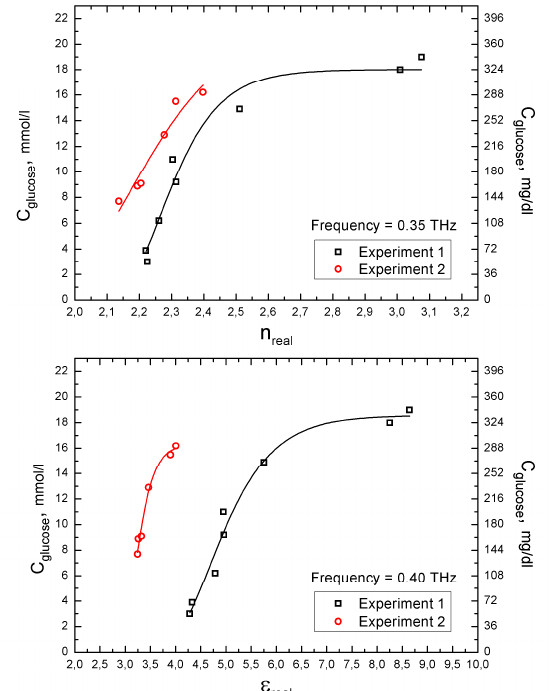
Fig. 2. Correlation behavior repeatability: for refractive index (top graph) as well as for permittivity (bottom graph) Experimental results represented above showed method sensitivity to glucose level on condition of stable concentrations of other blood components (there were single patient during experiments). To estimate variability there were about 50 biosamples extracted from different patients, where concentration of components varies at each patient. [5] Each blood sample was analyzed for concentration of glucose, bilirubin, triglycerides, creatinine and uric acid by standard clinic laboratory tests. To observe influence of each component concentration on blood optical properties, observed parameters had been grouped by following principle: one parameter is varied, other are